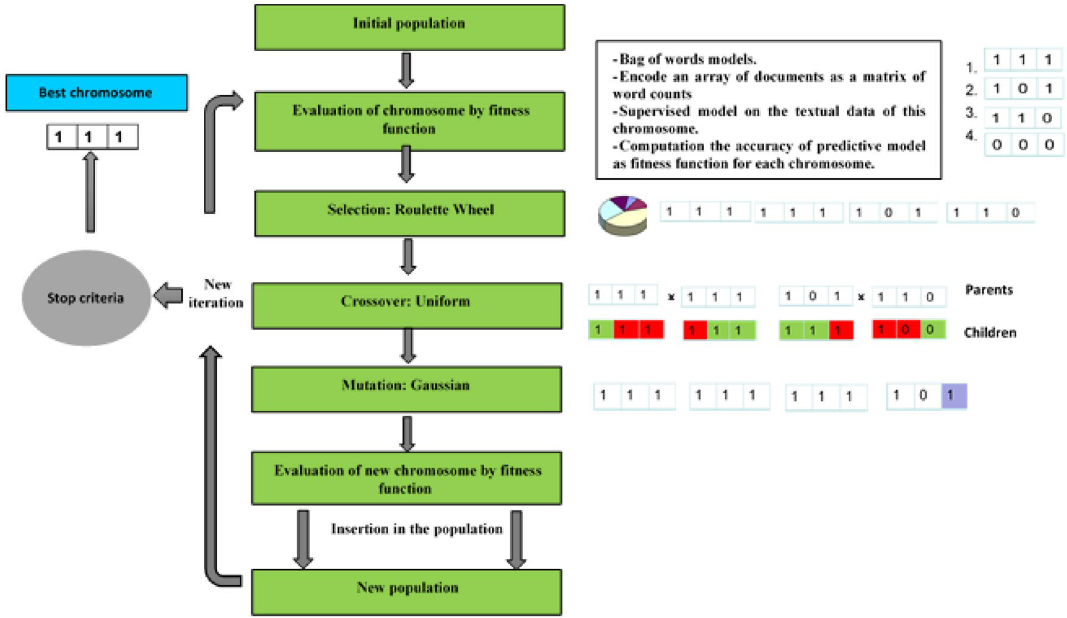
Figure 1. Synoptic representation of the proposed GA